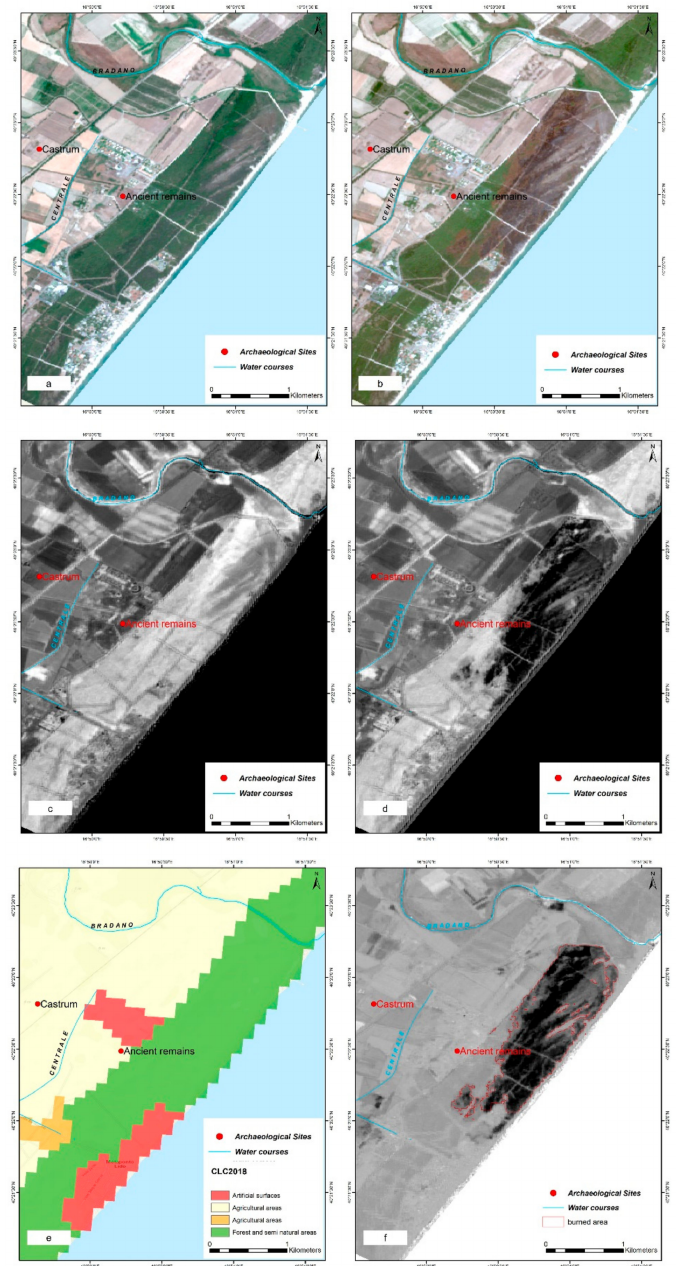
Figure 13. ( a ) S-2 RGB pre-fire image; ( b ) S-2 RGB post-fire image; ( c ) NBR greyscale pre-event; ( d ) NBR greyscale post-event; ( e ) Corine Land Cover 2018; ( f ) ∆ NBR greyscale with perimeter of the burnt area automatically extracted by the